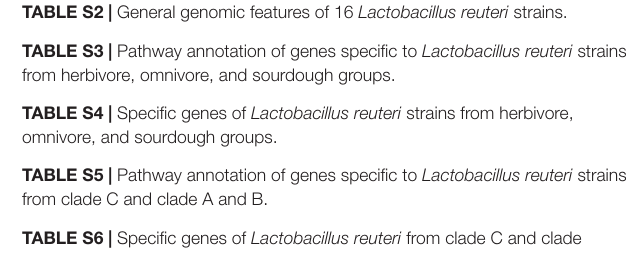
FIGURE S1 | The average nucleotide identity value of 37 Lactobacillus reuteri genomes. FIGURE S2 | Annotation of 37 Lactobacillus reuteri genomes by Rapid Annotation using Subsystem Technology tool. (A) Functional genes of each genome. (B) Distribution of each functional catalog in genomes of 37 strains. FIGURE S3 | Core and pan-genomes of Lactobacillus reuteri isolates. The gene accumulation curves show the number of total genes (pan-genome) and conserved genes (core-genome) obtained by adding a new genome to a previous set. FIGURE S4 | The distribution of single nucleotide polymorphisms count per 1000 bp. TABLE S1 | Sample information of 37 Lactobacillus reuteri